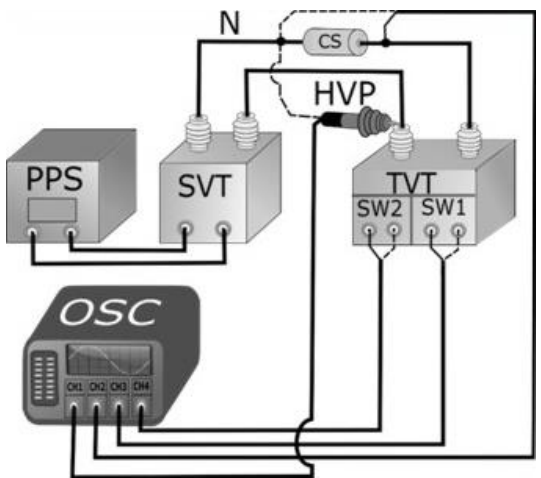
Figure 3. The measuring circuit used to determined magnetization characteristic of the magnetic core of tested VT, where PPS—programmable power supply system, SVT—step-up voltage trans-